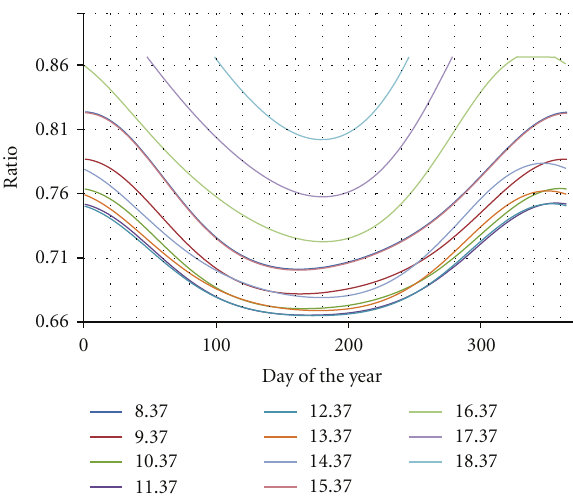
Figure 9: Ratio values of mirror 3 along the year (one-hour